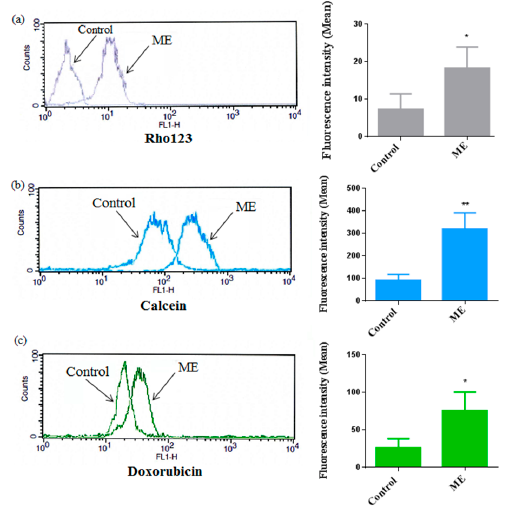
Figure 7. Cellular uptake of Rho123 and calcein by Caco-2 cells after treatment with ME (IC 50 ) for 2 h; data are illustrated as a representative measurement of the accumulation (on the right column of the figure), and the histograms of the average of fluorescence intensity (left column) of Rho123 ( a ), calcein ( b ) and doxorubicin ( c ); cells treated with 0.1% DMSO were used as a negative control. The values are reported as an average of measurements mean ± standard deviation of approximately 10,000 cells in each triplicate tested sample. * p < 0.05; ** p < 0.01 compared to the negative